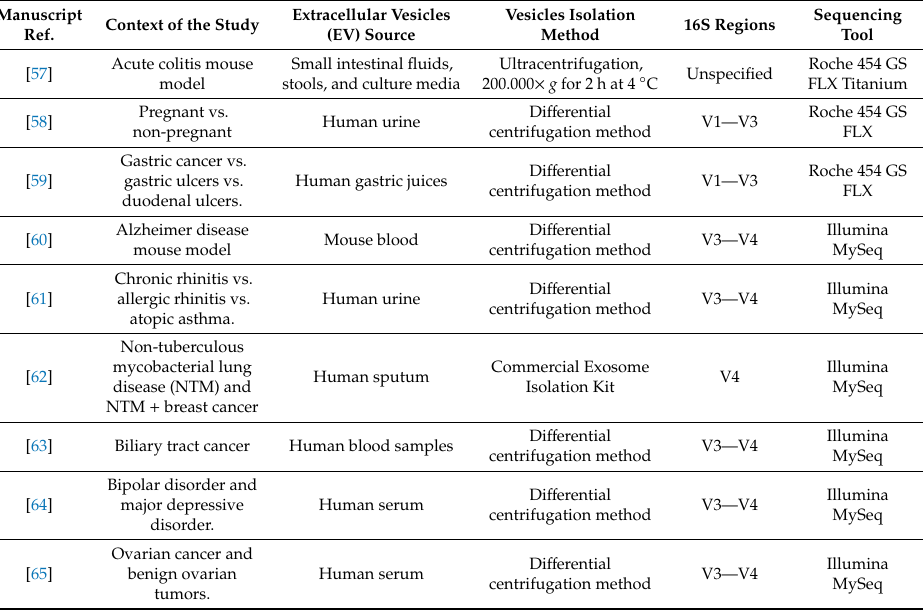
Table 1. Extracellular vesicles-based studies investigating circulating